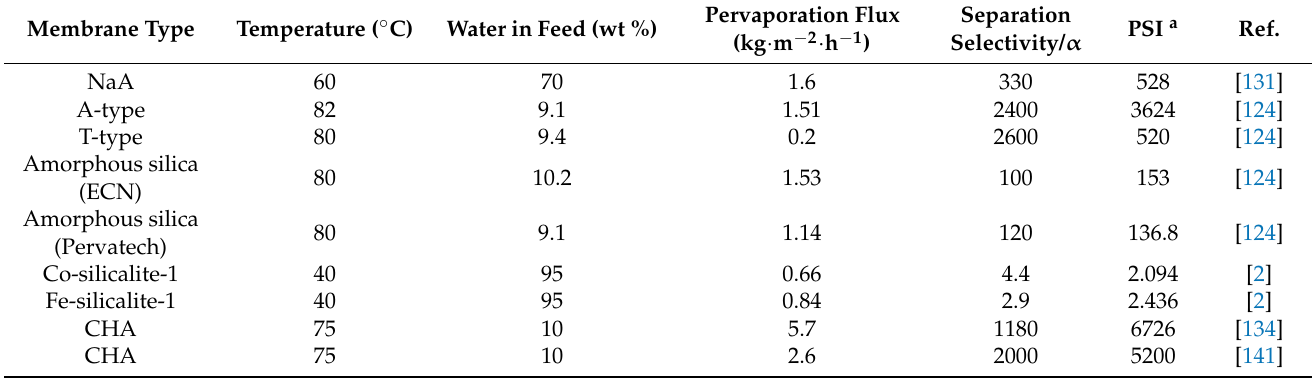
Table 4. Comparison of parameters of different inorganic membranes in DMF